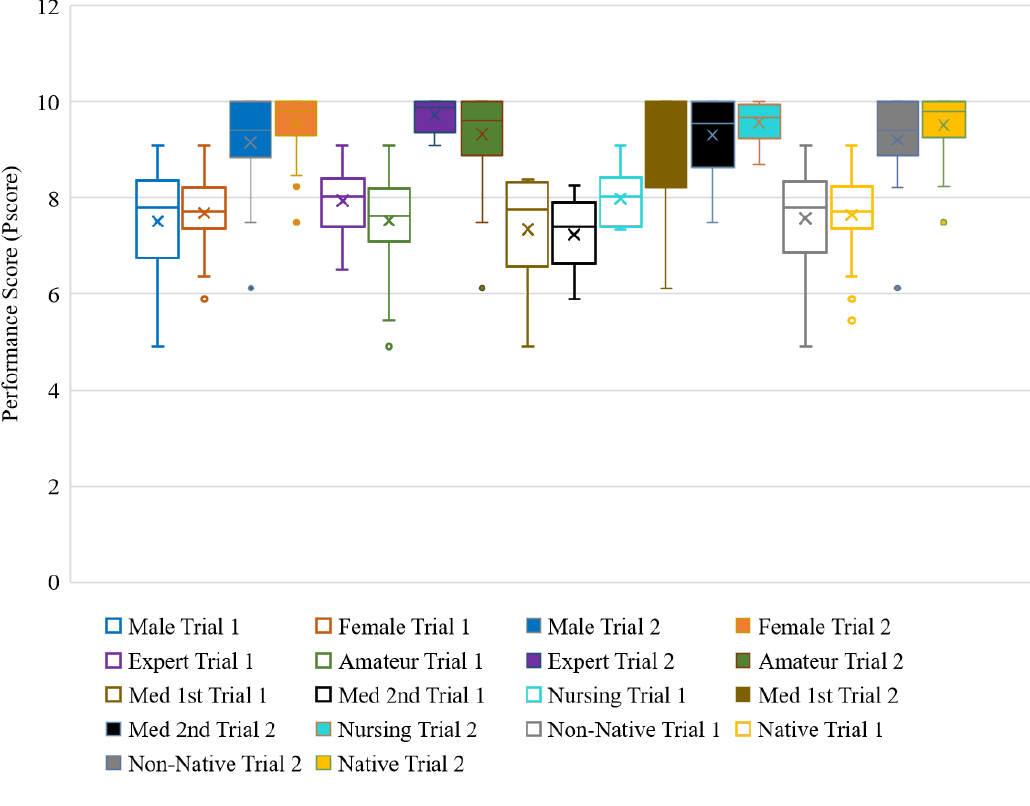
Figure 10. P-score comparison among HMT identified